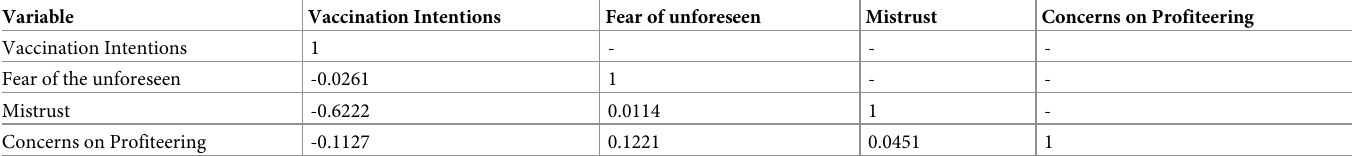
Table 6. Pairwise correlation between vaccination intentions, fear of the unforeseen, mistrust and concerns on profiteering.